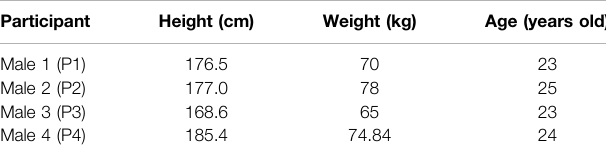
TABLE 1 | Anthropometric characteristics of the participants. P1, P2, P3, and P4 represent the fi rst, second, third, and fourth participant.